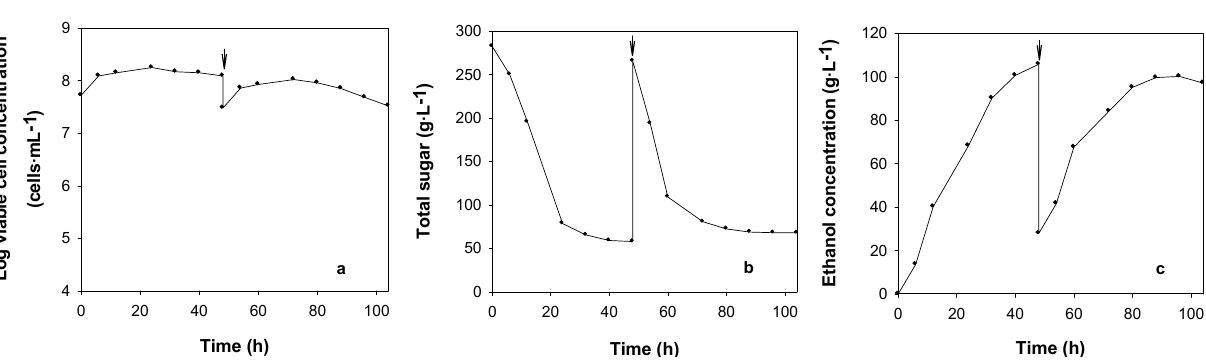
Figure 3. Fermentation parameters during two cycles of repeated-batch ethanol production from sweet sorghum juice containing 280 g·L − 1 of total sugar and 21 g·L − 1 of DSY (dried spent yeast) in the 2-L fermenter. ( a ) log viable yeast cells; ( b ) total sugar; ( c ) ethanol concentration. The arrows indicate the start time of each